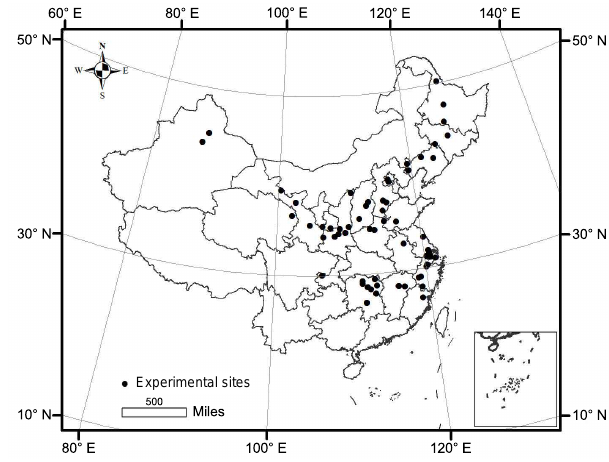
Figure 1. Locations of the long-term experiment sites in the study